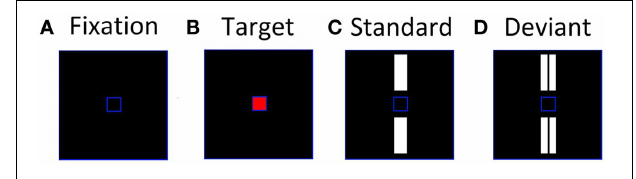
FIGURE 1 | Stimuli used to elicit visual evoked potentials, (A) inter-stimulus screen; (B) attended target; (C) unattended standard; (D) unattended